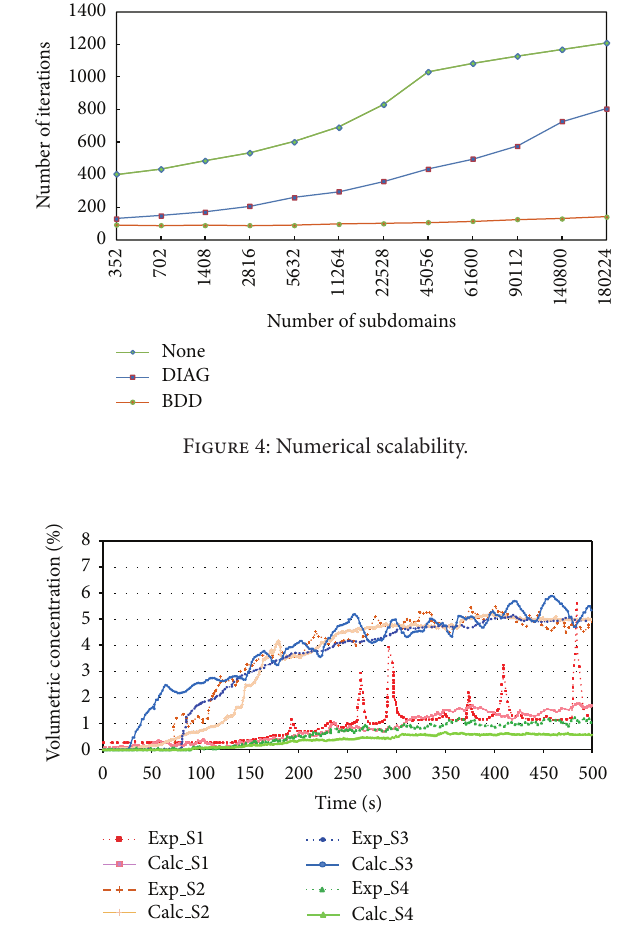
Figure 5: Numerical results versus experimental results.